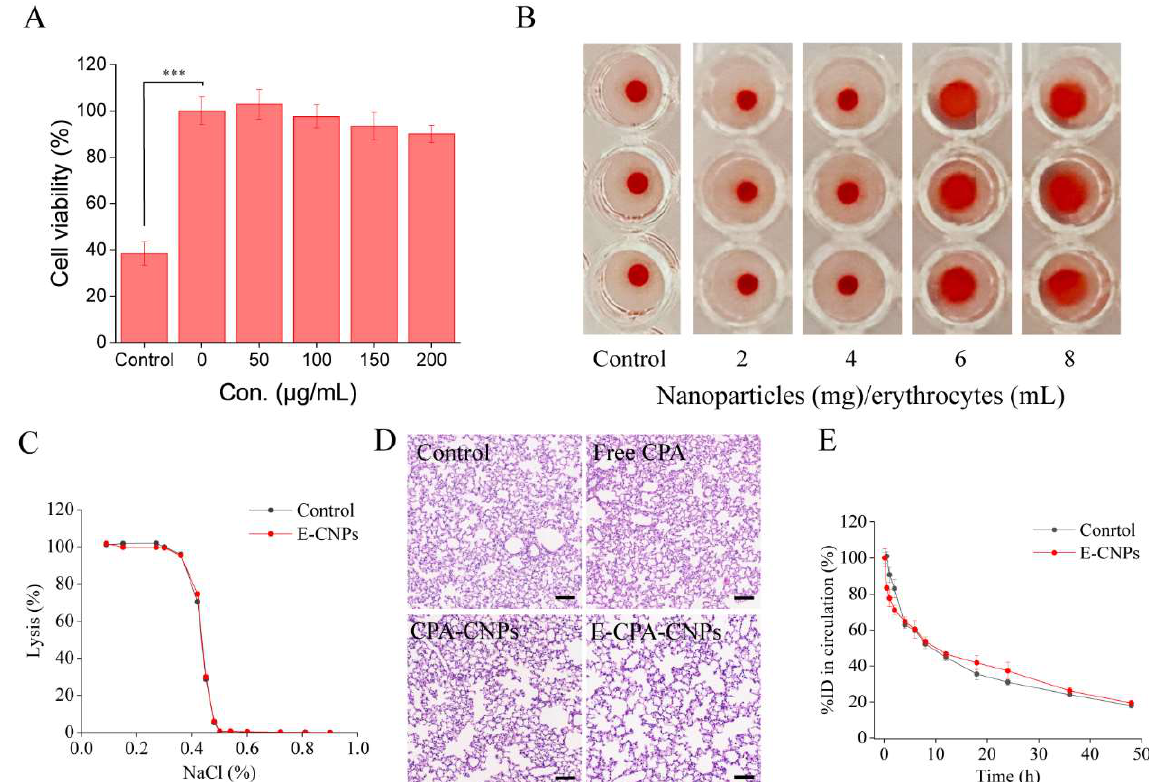
Figure 4. Safety evaluation of E-CNPs. ( A ) Relative cell viability of HUVEC after incubation with different concentrations of CPA-CNPs for 48 h ( n = 5, mean ± SD). ( B ) Hemagglutination caused by CNPs adhesion in U-shaped 96-well plates ( n = 3). Unaggregated erythrocytes settle into tight spots at the bottom of the U-plate, while aggregated erythrocytes formed a film over the entire surface of the well. ( C ) Osmotic fragility of free erythrocytes and E-CPA-CNPs ( n = 3, mean ± SD). ( D ) H&E staining of lung sections from healthy mice injected with various CPA-loaded formulations (scale bar = 100 µ m). ( E ) The circulation time of DiI-labeled free erythrocytes and E-CPA-CNPs in vivo. %ID refers to the percentage relative to the injected dose ( n = 3, mean ± SD, *** p <